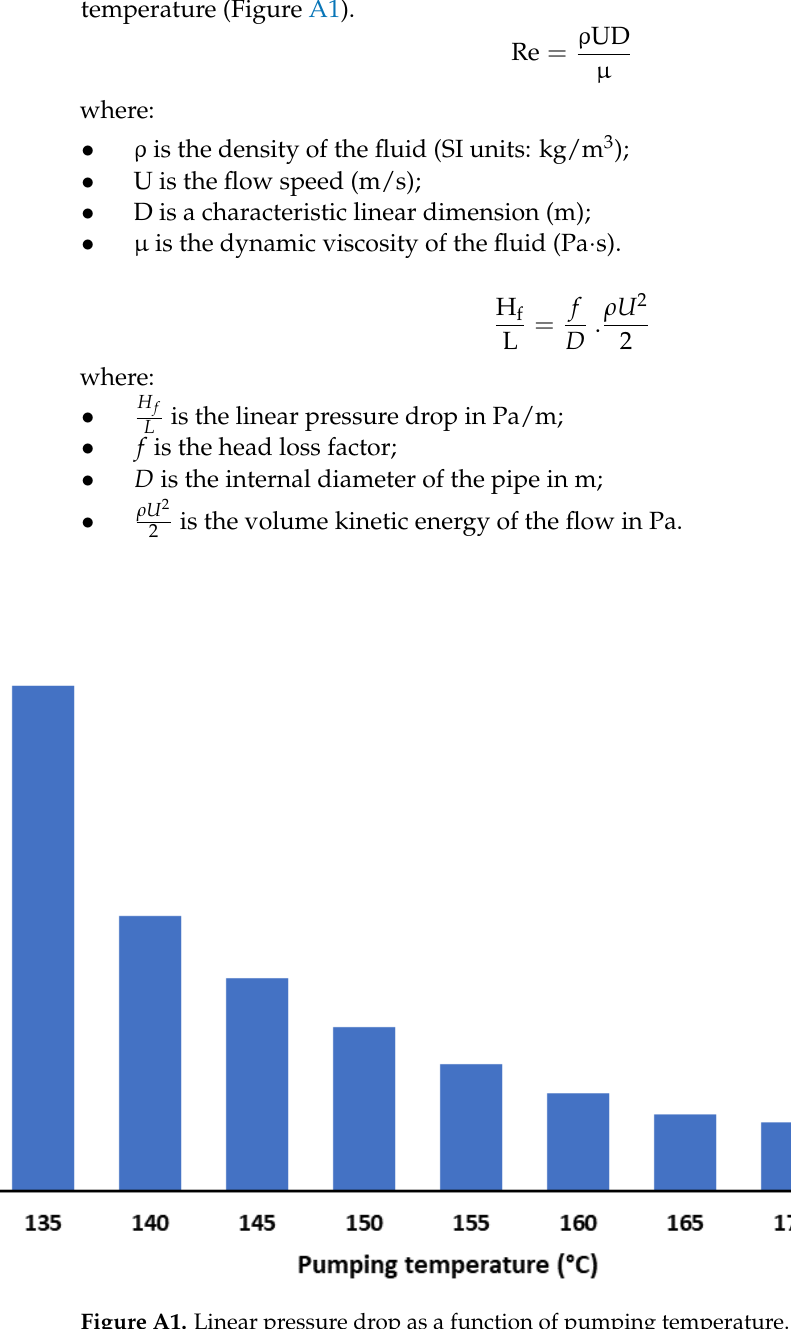
Figure A1. Linear pressure drop as a function of pumping temperature.